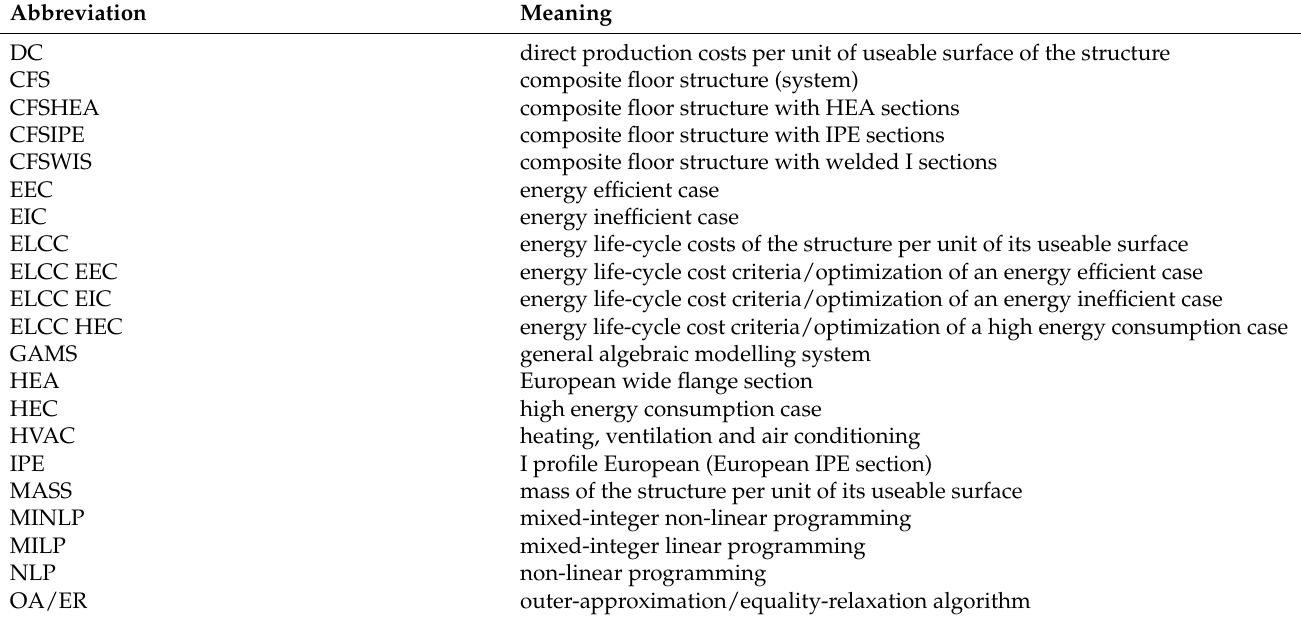
Table 1. List of